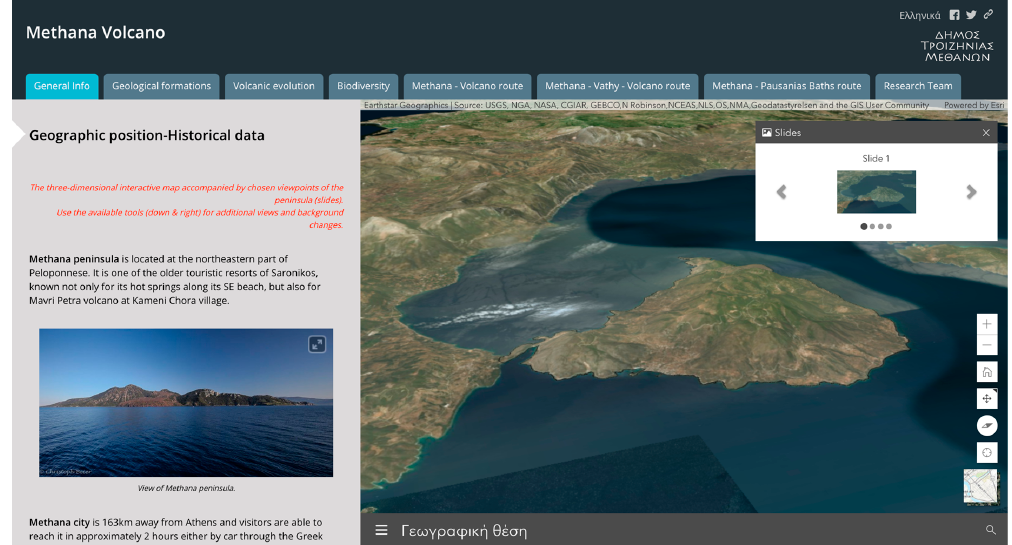
Figure 6. Screenshot of the first Story Map Series—Accordion tab, where general information about the geographical position of the Methana peninsula and its historical evolution is given (https://goo.gl/UR1a9k).